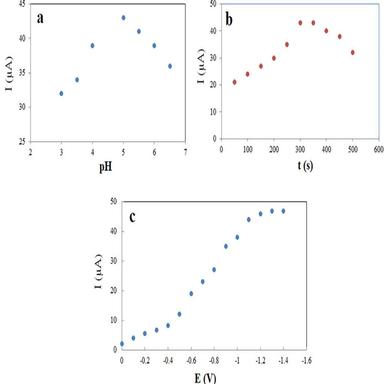
Influence of (a) pH value, (b) deposition time and (c) deposition potential on DPASV responses of GO-imi- (CH2)2-NH2 /CPE in acetate buffer (pH 5.0) containing 300.0 nM Pb(II).